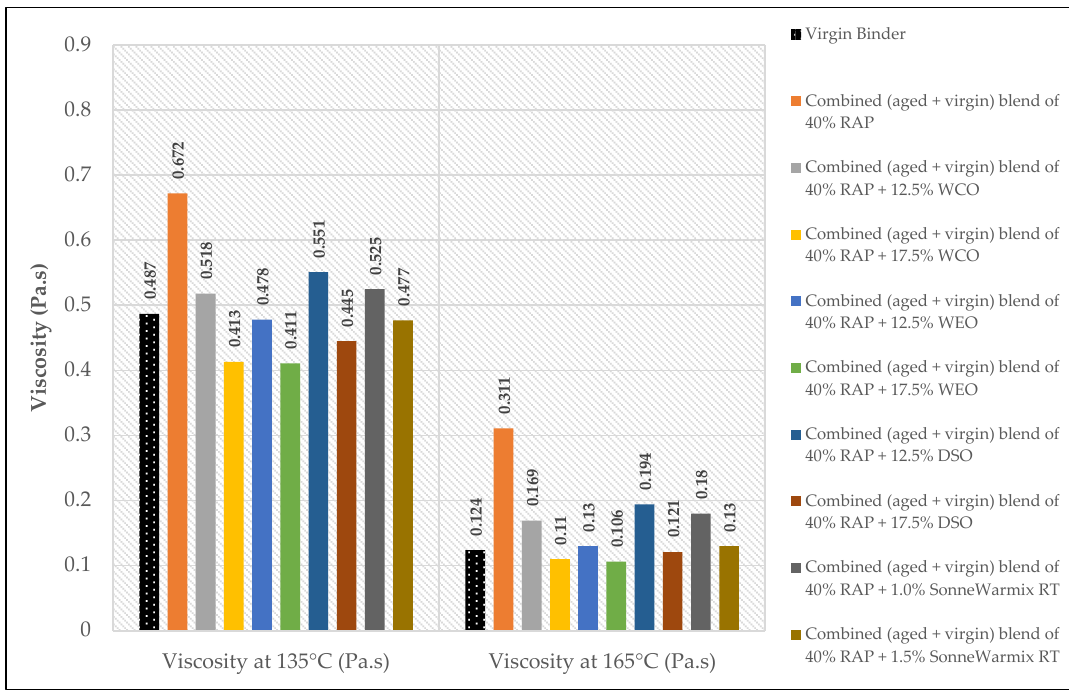
Figure 15. Rotational viscosity of combined (aged + virgin) binder blend of 40% RAP.